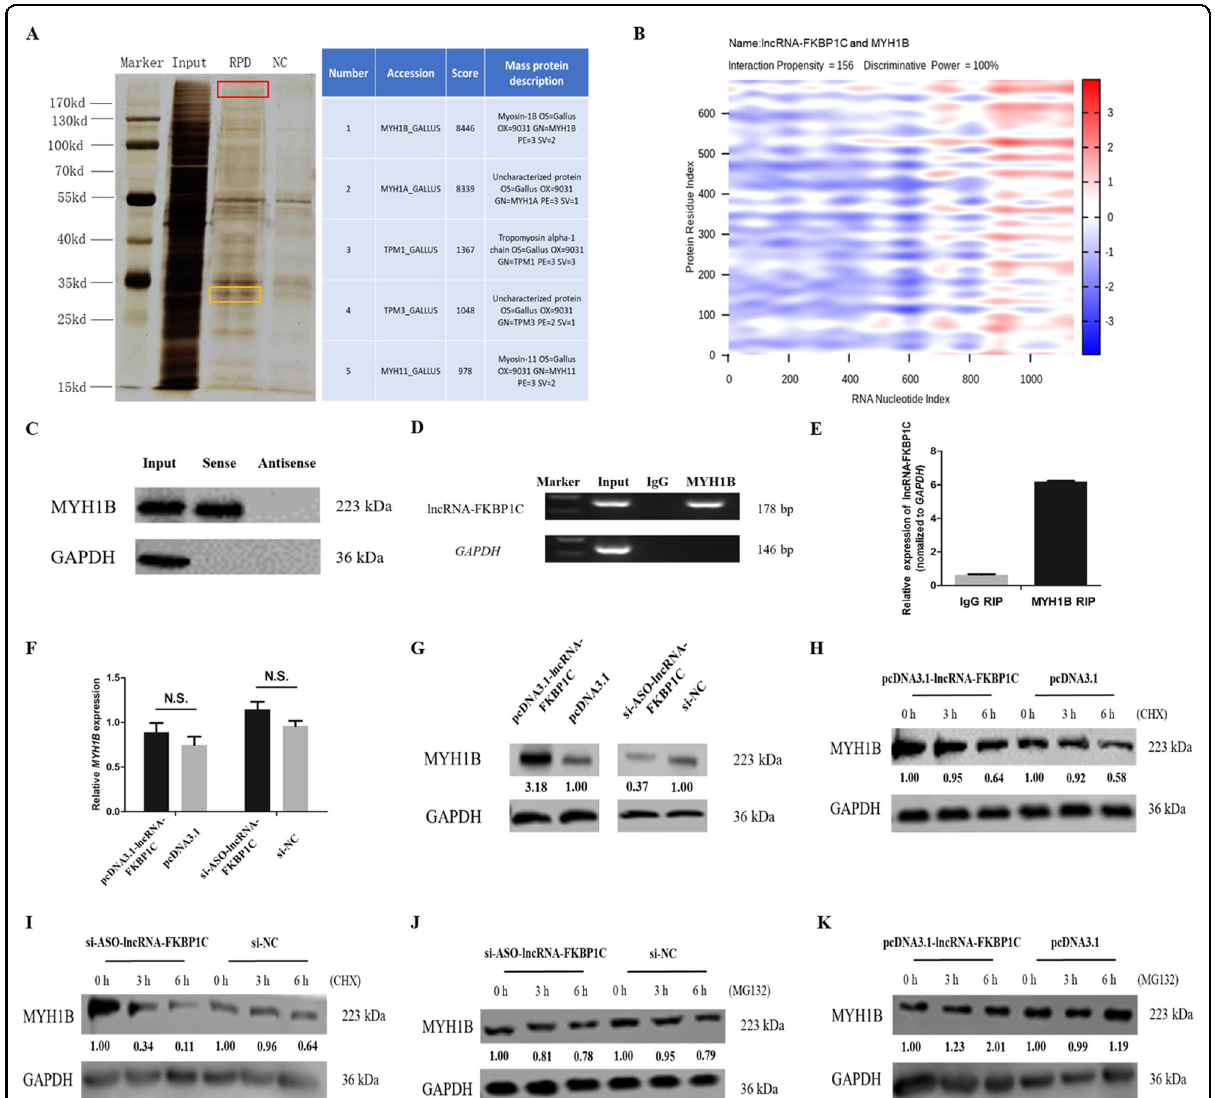
Fig. 5 LncRNA-FKBP1C interacts directly with MYH1B and increases the protein level of MYH1B by enhancing its protein stability. A RNA pulldown silver stained image and binding proteins screened by mass spectrometry. Red box indicates MYH1A, MYH1B and MYH11 proteins; yellow box indicates TPM1 and TPM3 proteins. B Prediction of the interaction between LncRNA-FKBP1C and MYH1B by using catRAPID (http://service. tartaglialab.com/page/catrapid_group). C, D Interaction between LncRNA-FKBP1C and MYH1B as determined by biotin-labeled RNA pulldown and RIP. E The qPCR result of RIP. F, G The mRNA and protein expression of MYH1B induced by LncRNA-FKBP1C overexpression and interference in CPM cells (N.S. is the abbreviation for not signi fi cant). H The CPM cells after 48 h transfected with pcDNA3.1-lncRNA-FKBP1C and pcDNA3.1 incubated with the protein synthesis inhibitor CHX (1 mg/mL) for 0, 3 or 6 h. I The CPM cells after 48 h transfected with si-ASO-lncRNA-FKBP1C and si-NC incubated with the protein synthesis inhibitor CHX (1 mg/mL) for 0, 3 or 6 h. J The CPM cells after 48 h transfected with si-ASO-lncRNA-FKBP1C and si-NC incubated with MG-132 (100 μ mol/L) for 0, 3 or 6 h. K The CPM cells after 48 h transfected with pcDNA3.1-lncRNA-FKBP1C and pcDNA3.1 incubated with MG-132 (100 μ mol/L) for 0, 3 or 6